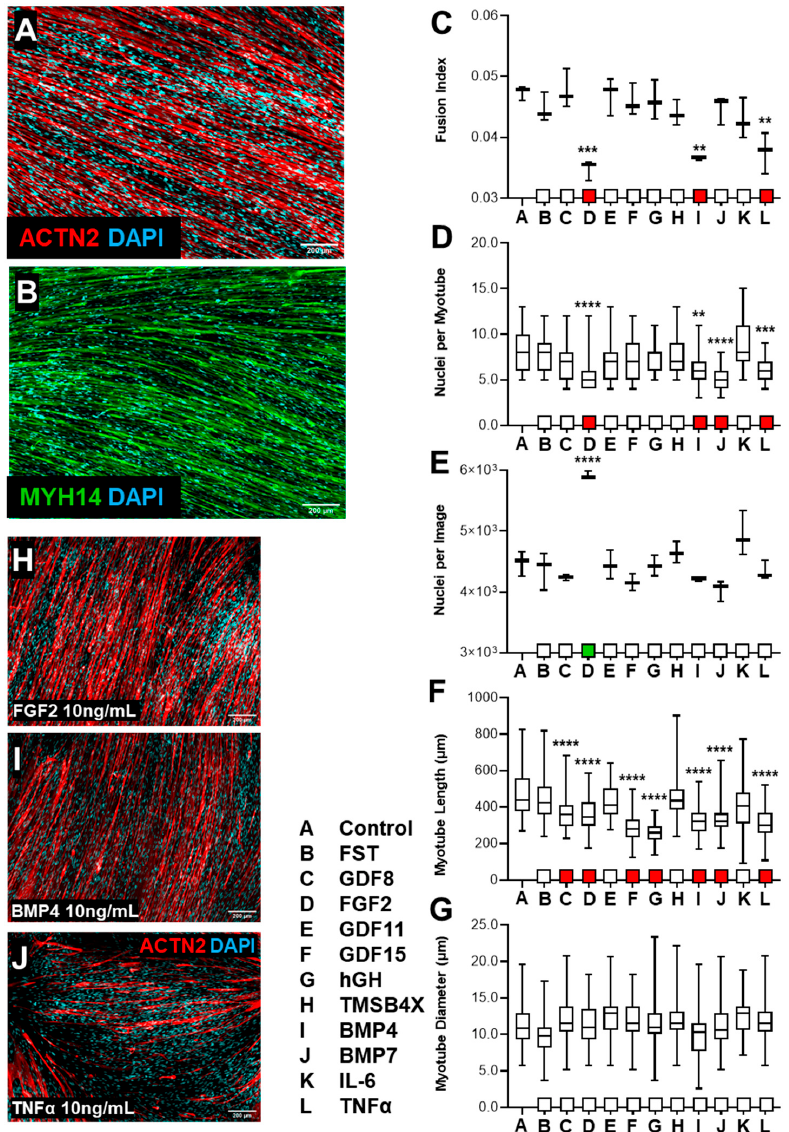
Figure 3. Evaluation of the differentiation of transdifferentiated Human Fibroblasts (tHFs) with the exposure of biological ligands. Human fibroblasts were induced to transdifferentiate into skeletal myoblasts via lentiviral transduction of MYOD1 gene integration, with expression promoted via doxycycline (Dox) and SB43154 (SB) incorporation. Cells were induced to transdifferentiate for 7 days with the administration of Dox and SB, and subsequently subject to ligands exposure (10 ng/mL) for an additional 7 days to determine the effect of biological ligands on skeletal muscle differentiation. ( A ) tHFs were immunostained with ACTN2 at 5 × microscopy. ( B ) MF20 staining established consistent observations with ACTN2 images. ( C ) Identification of tHF myotube fusion index was derived from the ratio of myonucleation level in all myotubes vs. overall nuclear count ( n = 3, mean + SD). ( D ) Quantification of cellular myotube nuclei was utilized to determine distribution of nuclei and thus multinucleation levels ( n = 30, mean + SD) and ( E ) to identify nuclear density of all cells, including those of un-transdifferentiated fibroblasts ( n = 3, mean + SD). ( F ) Myotube length ( µ m) and ( G ) diameter ( µ m) derived from ACTN2+ cells were also quantified ( n > 60, mean + SD). ( H ) Nuclear density of cells exposed to FGF2 significantly increased, while also showing lower myotube length, fusion index, and multinucleation as compared to control. ( I ) BMP4 and ( J ) TNF- α exposure suggested limited proliferation capacity of transdifferentiated skeletal myotubes, myonucleation, and average myotube length. ** p < 0.01, *** p < 0.001, **** p <